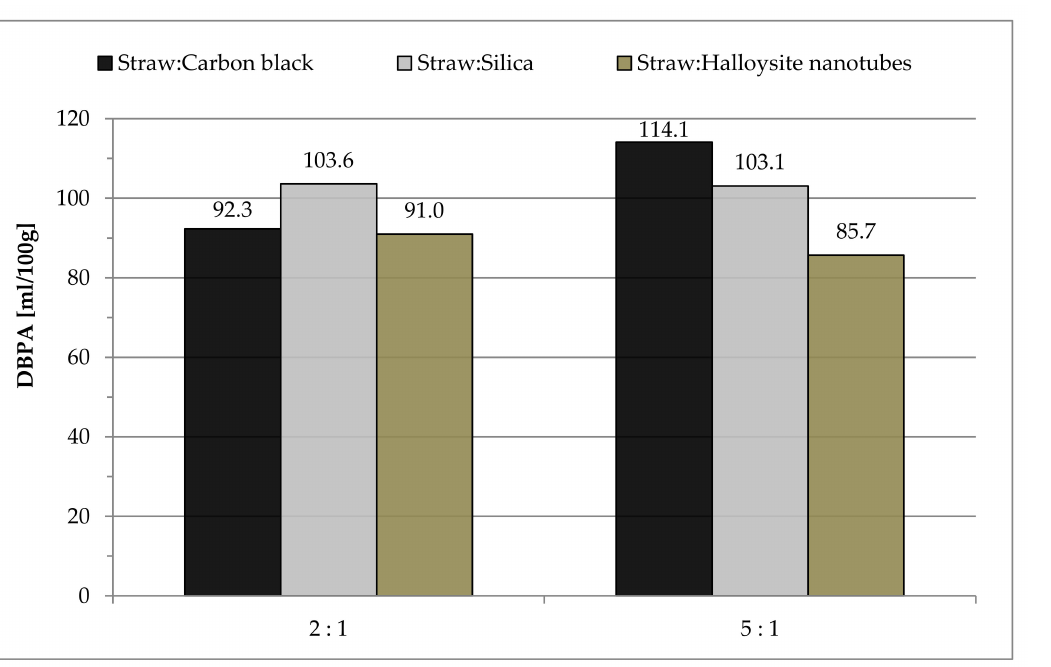
Figure 2. The DBPA (n-dibutyl phthalate absorption) value of hybrid